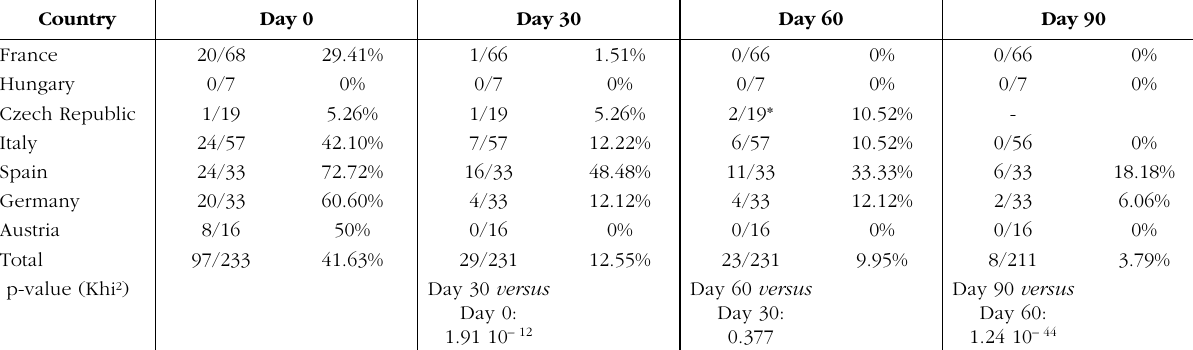
Table III. – Results of flea infested dogs per country during the survey.